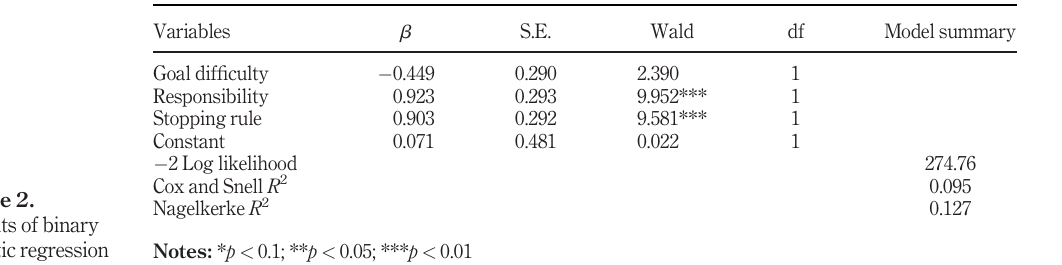
Table 2. Results of binary logistic